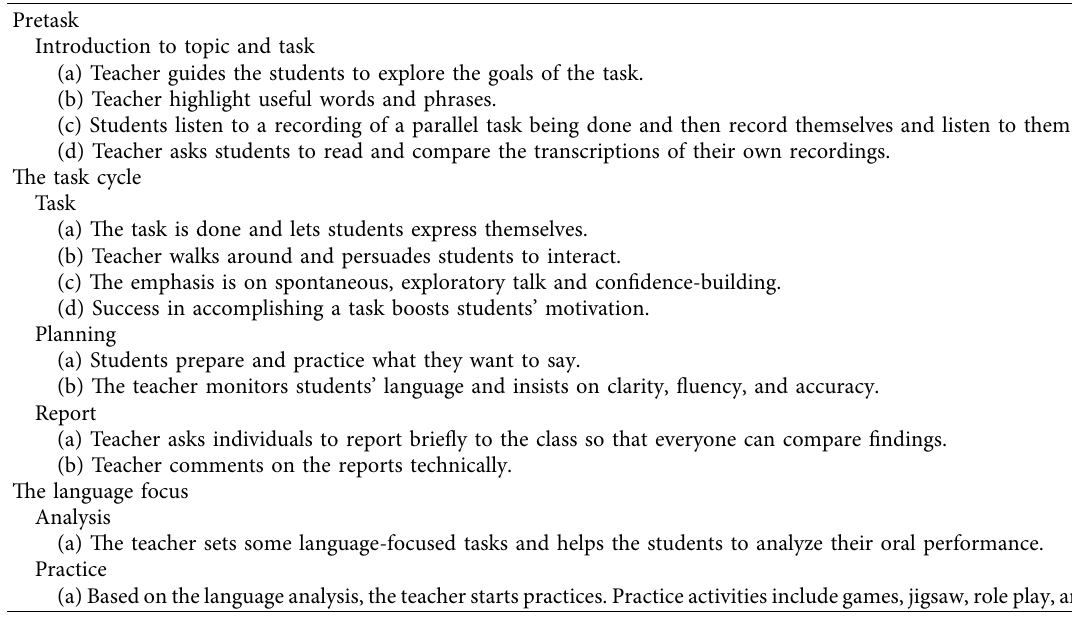
Table 1: Task-based language teaching framework.